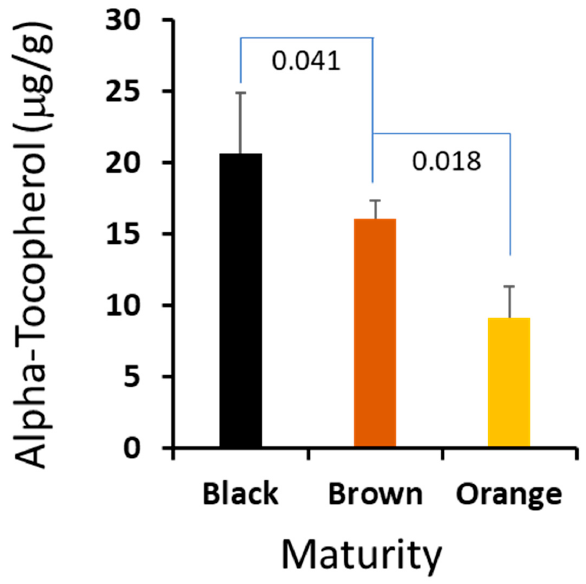
Figure 2. The α -tocopherol contents in the peanuts’ hearts are correlated to the maturity. The error bars are standard deviation of 5 independent measurements and the p -values of Student’s t -test between the maturity stages. Table 2. Phytosterol and Isoprenoid Composition of Arachis hypogaea Seed Hearts of Different Classes.